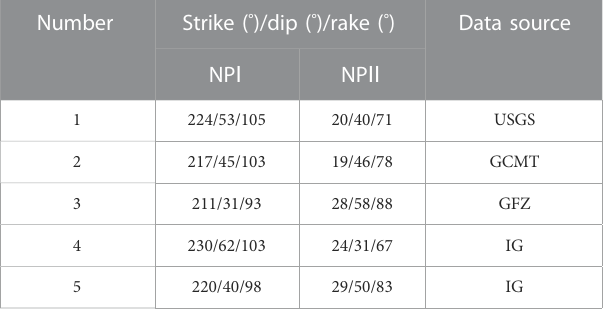
TABLE 1 Focal mechanisms of the 2022 M S 6.1 Lushan earthquake given by various research institutions. Number Strike ( ° )/dip ( ° )/rake ( ° ) Data source NP Ⅰ